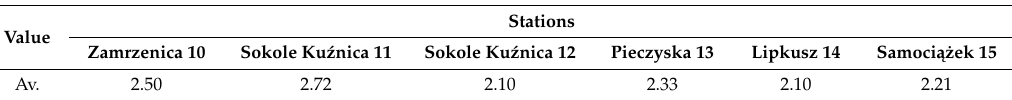
Table 3. Average values of total suspended material (mg L − 1 ) along the longitudinal profile of Koronowski Reservoir in the hydrological year